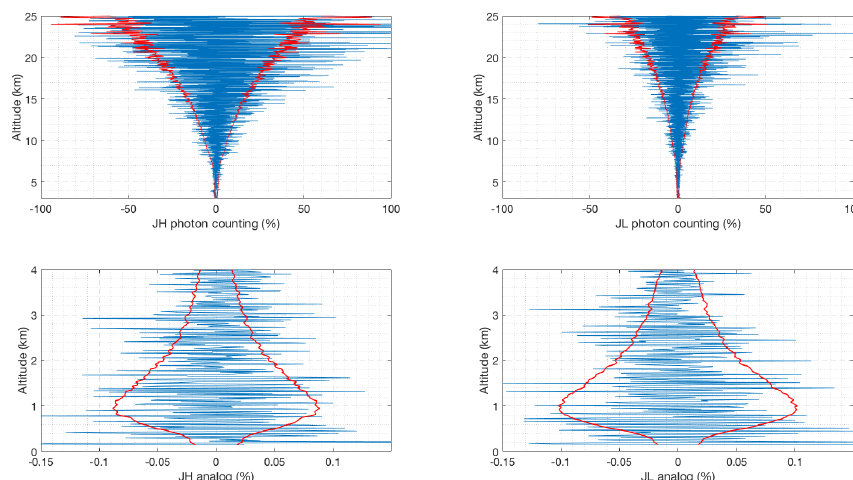
Figure 13. Difference between the forward model and the nighttime RALMO measurements on 5 July 2011 with the presence of a cirrus cloud for the four signals (blue). The red curves show the standard deviation of the measurements.